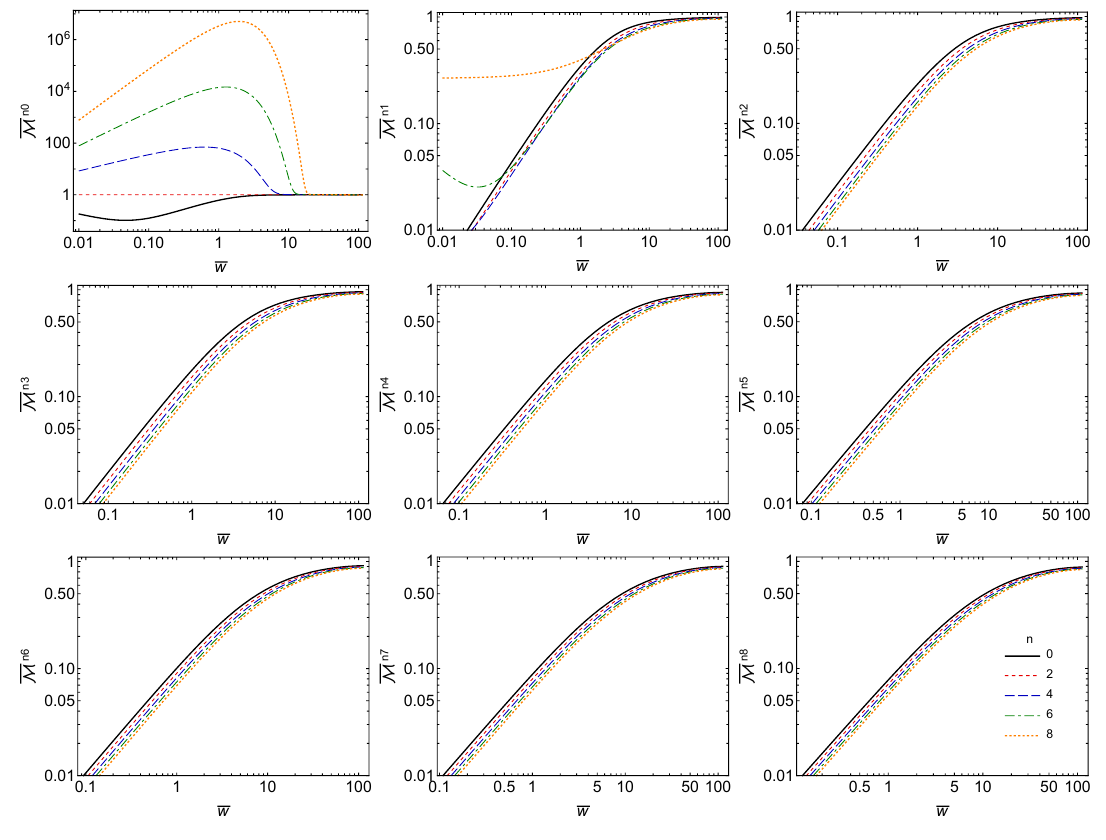
Figure 6 . Scaled moments M nm obtained from the exact attractor solution. Panels show m 2 f 0 (cid:1) (cid:1) (cid:1) 8 g and inside each panel the set of lines correspond to n 2 f 0 (cid:1) (cid:1) (cid:1) 8 g . I have only plotted the even values of m . As one sees from (cid:12)gure 5, for (cid:12)xed n and m > 0, increasing m results in a larger deviation from unity which indicates that higher longitudinal momenta take longer to equilibrate. The same results are plotted in (cid:12)gure 6, however, for this (cid:12)gure each panel corresponds to a (cid:12)xed value of m and the lines in each panel correspond to di(cid:11)erent values of n . Focusing (cid:12)rst on the upper left panel of (cid:12)gure 6, n 0 one sees that the prediction that M should increase in magnitude at early times as n is increased due to squeezed modes is borne out by the results. The other panels demonstrate that, for (cid:12)xed m , increasing n results in slower thermalization. Again this is consistent with the slower relaxation of high momentum